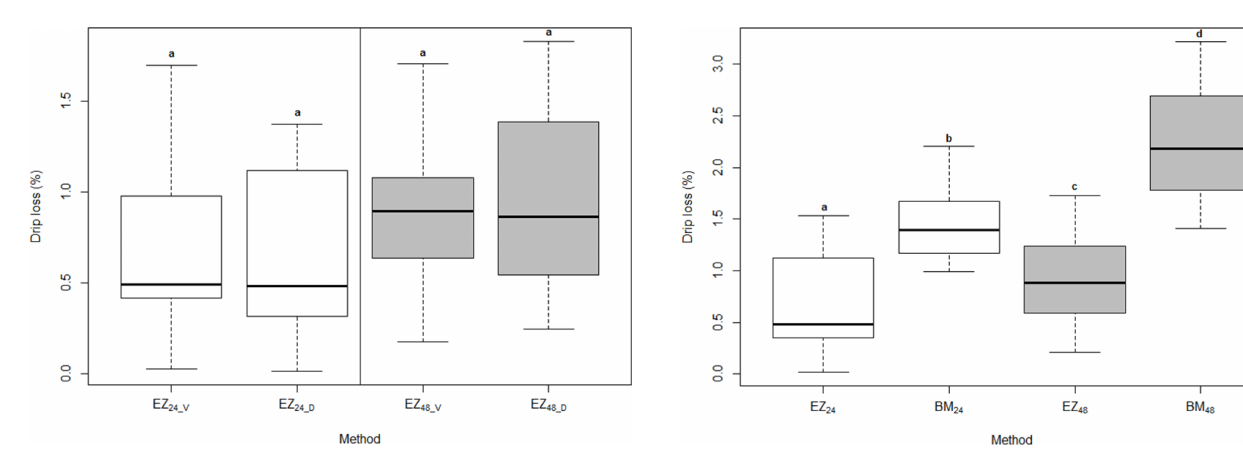
Figure 2. Distributions of drip loss obtained by BM and EZ meth- ods after 24 and 48h. For abbreviations see Table 1. Letters rep- resent the results of paired t test. Different letters in the same row significantly differ ( p< 0 .